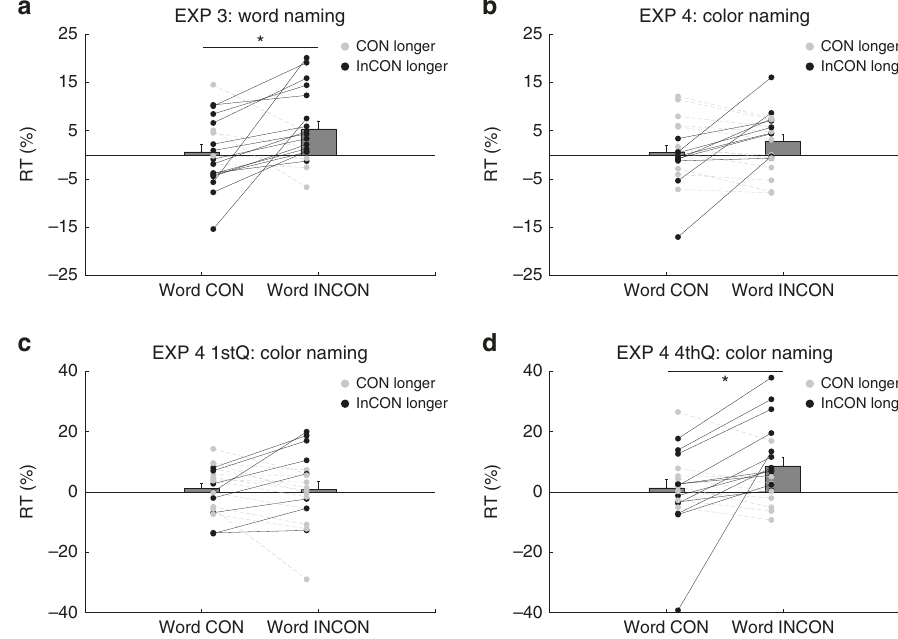
Fig. 3 Experiments 3 and 4 results. n = 20 in each experiment. Y -axis denotes reaction time, and X -axis denotes two critical conditions: word congruent (Word CON) and word incongruent (Word INCON). Black dots and lines denote longer RT in the word incongruent condition while gray dots and lines denote longer RT in the word congruent condition. Each pair of dots represents one participant. The bars denote group mean with the error bars indicating standard error of the mean (SEM). Asterisk denotes signi fi cance (A: Exp 3: p = 0.03; D: Exp 4 4th quarter trials: p = 0.02. Both 2-tailed paired t